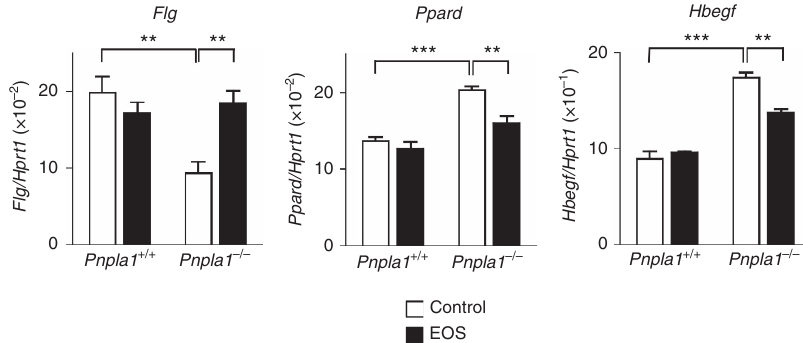
Figure 5 | Cer EOS partially rescues aberrant differentiation of Pnpla1 (cid:2) / (cid:2) keratinocytes. qPCR analysis of gene expression in Pnpla1 -deficient and control keratinocytes treated with 1.2mM CaCl 2 for 48h. EOS was added to the culture medium at 10 m M for the last 24h. Data are presented as the mean ± s.e.m. ( n ¼ 4; ** P o 0.01 and *** P o 0.001). Results are representative of two